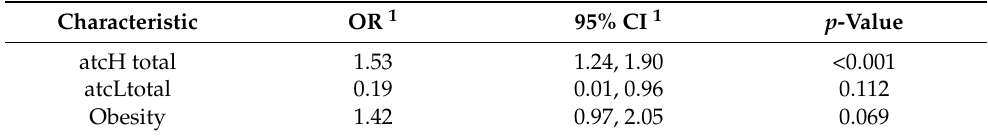
Table 2. Adjusted odds ratios for prolonged postoperative length of stay after variable selection using a backward elimination algorithm with Akaike Information Criterion as stopping criterion.